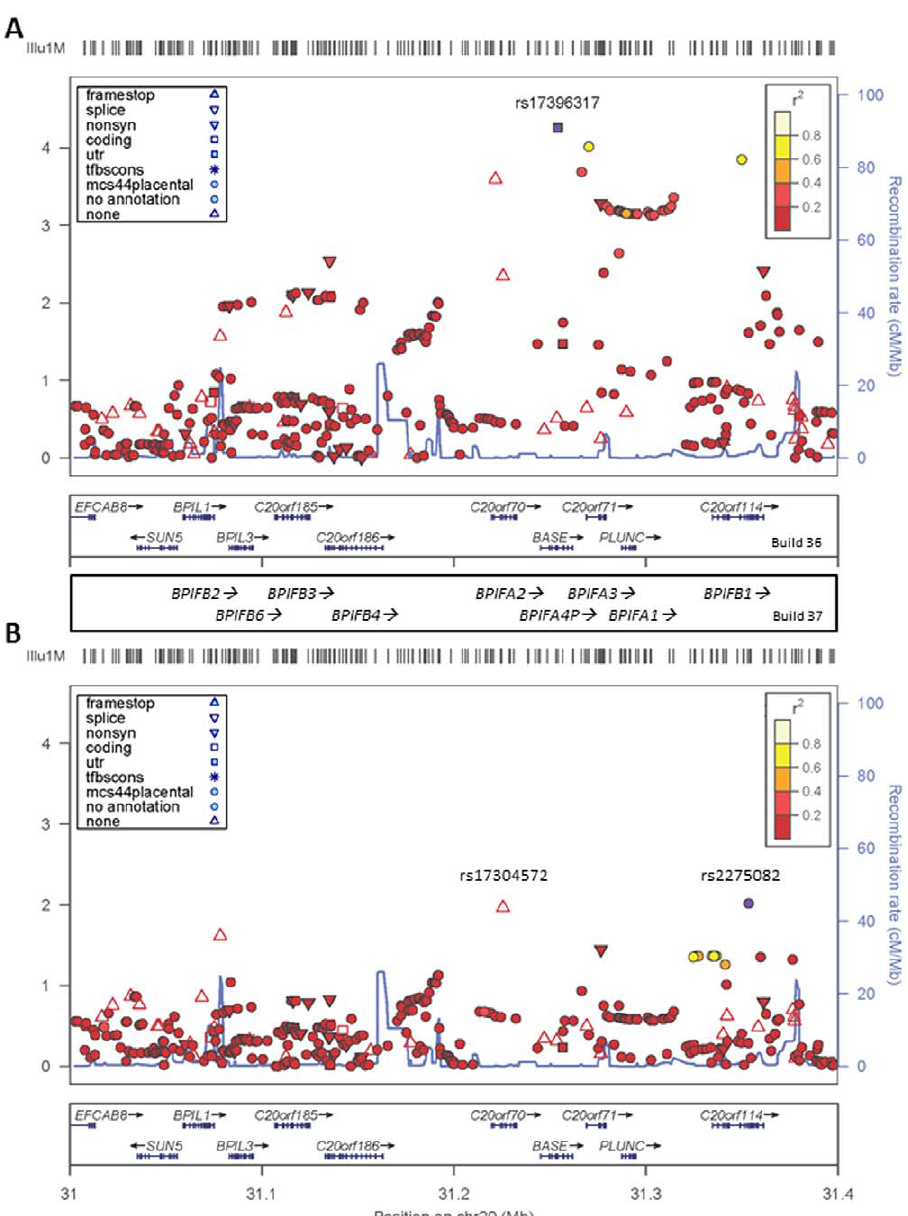
Figure 2. Regional LocusZoom plots of association across the region of chromosome 20 containing the BPIFA genes. (A) LocusZoom plots of association in the imputed dataset adjusted for PCs across the BPIFA4P-BPIFA3-BPIFA1 gene region in the full discovery set of 1491 Raine Study participants. (B) The same region after adjusting for the top SNP rs17396317. The top associated SNP (rs17396317) is represented by purple circle in (A), the colour of all other SNPs is representative of the pairwise r 2 value with the relevant top SNP using patterns of LD from the Raine Study cohort. Recombination rates are shown by the solid blue line. Physical positions and gene designations are based on NCBI Build 36 of the human genome. Gene designations for NCBI Build 37 are indicated in the panel between (A) and